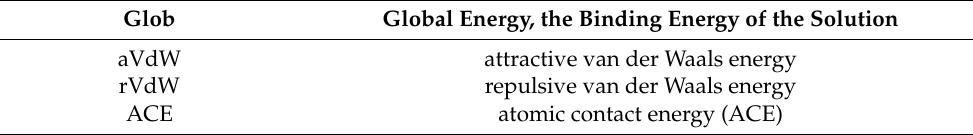
Table 2. The different features that define the energy states associated with the interactions between the different spike proteins and the α 7nAChr. Glob aVdW attractive van der Waals energy rVdW